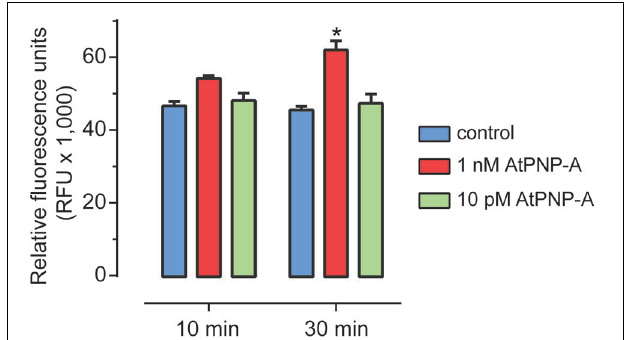
FIGURE 2 | ROS accumulation following AtPNP-A treatment. ROS accumulation after treatment of suspension-cultured cells of A. thaliana (Col-0) with AtPNP-A. Relative fluorescence was measured at 10 and 30min post-treatment. Data are mean ± s.e.m. of three biological replicates ( n = 3). The bar with an asterisk ( ∗ ) indicates data that is significantly different ( p -value < 0.05; Two-Way ANOVA, Tukey